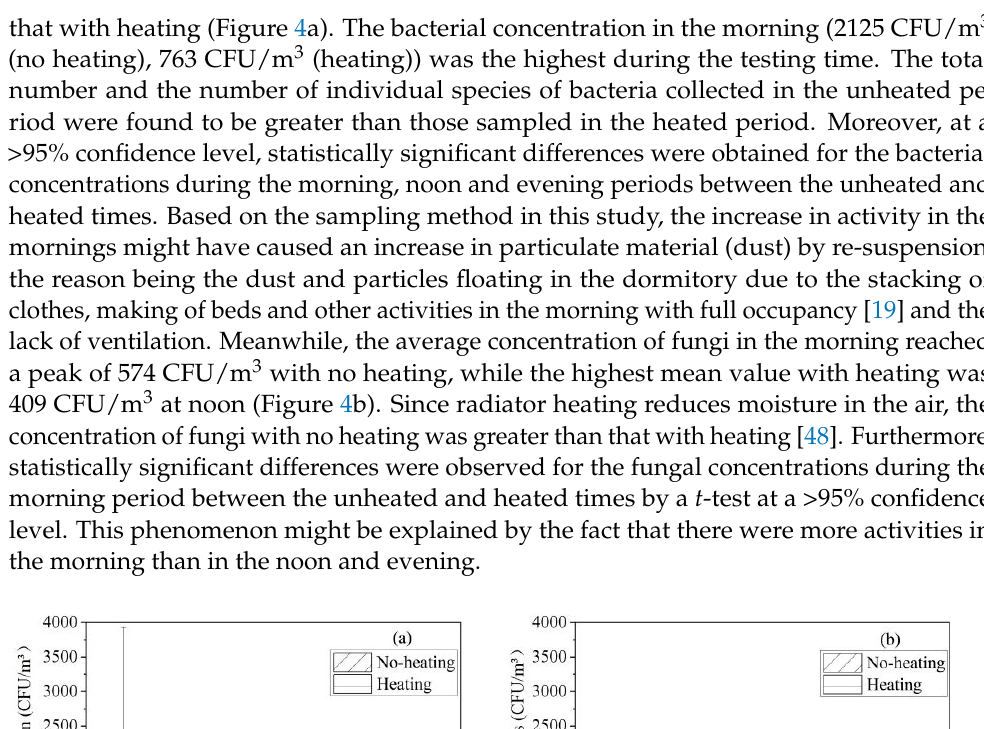
Figure 5. Relationship between the concentrations of microbes and the number of female occupants in the dormitory.